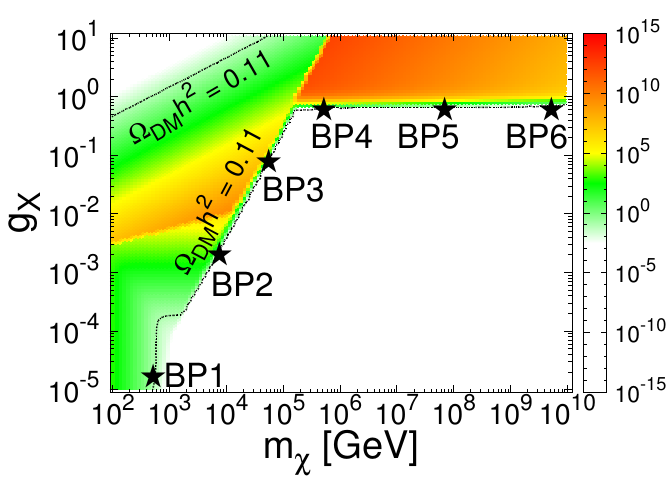
Figure 5 . Ω DM h 2 for the SU(2) X Model with h h i QCD = 100 MeV . The black-dashed contours indicate the observed DM relic abundance, Ω DM h 2 = 0 . 11 . The stars mark the six benchmark points in table